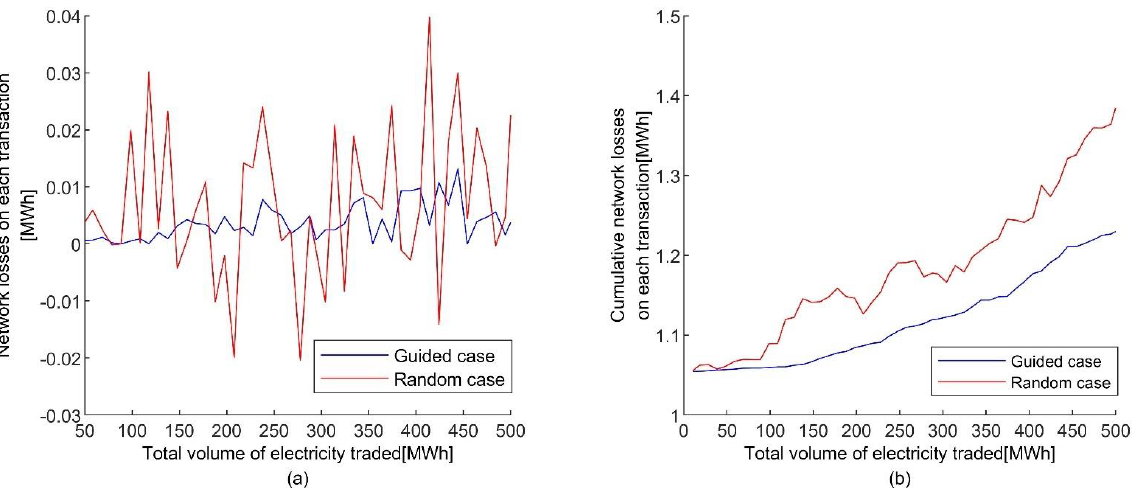
Figure 9. Network losses on each transaction with 10 MWh transaction limit in the IEEE 39 bus case: ( a ) network losses on each transaction; ( b ) cumulative network losses on each transaction.